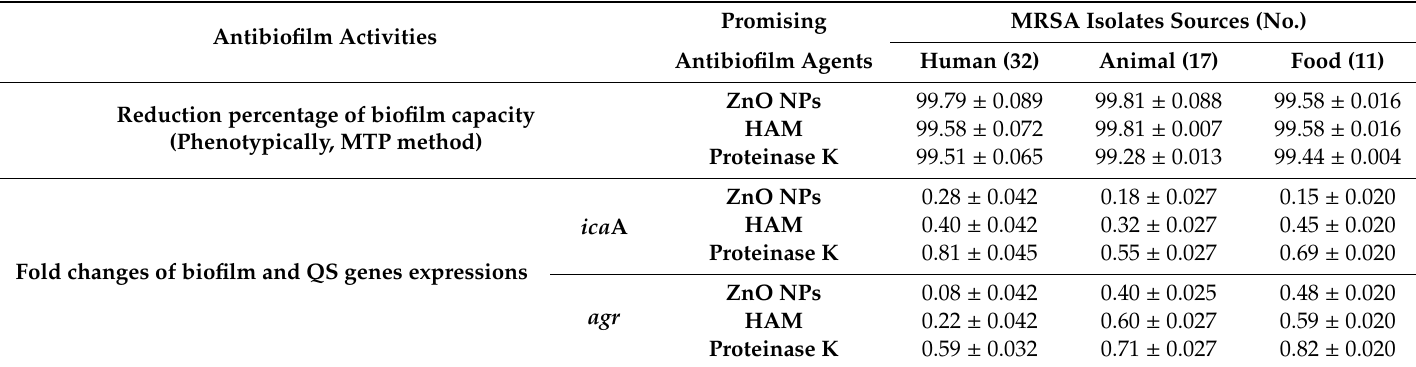
Table 2. Summary of antibiofilm activities of promising antibiofilm agents against biofilm producing methicillin-resistant Staphylococcus aureus isolates from various